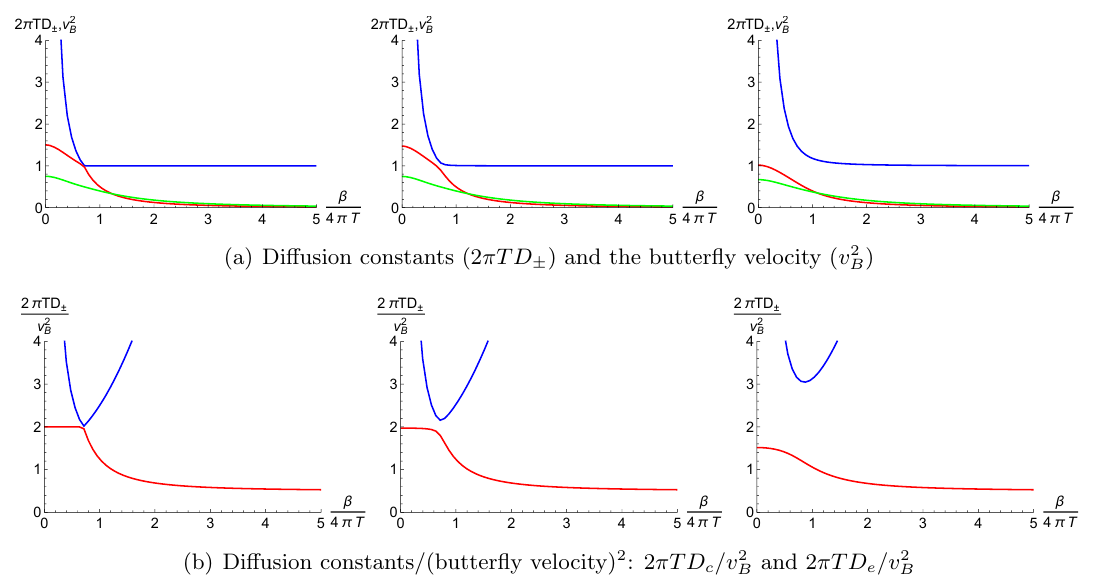
(b) Di(cid:11)usion constants/(butter(cid:13)y velocity) 2 : 2 (cid:25)TD c =v 2